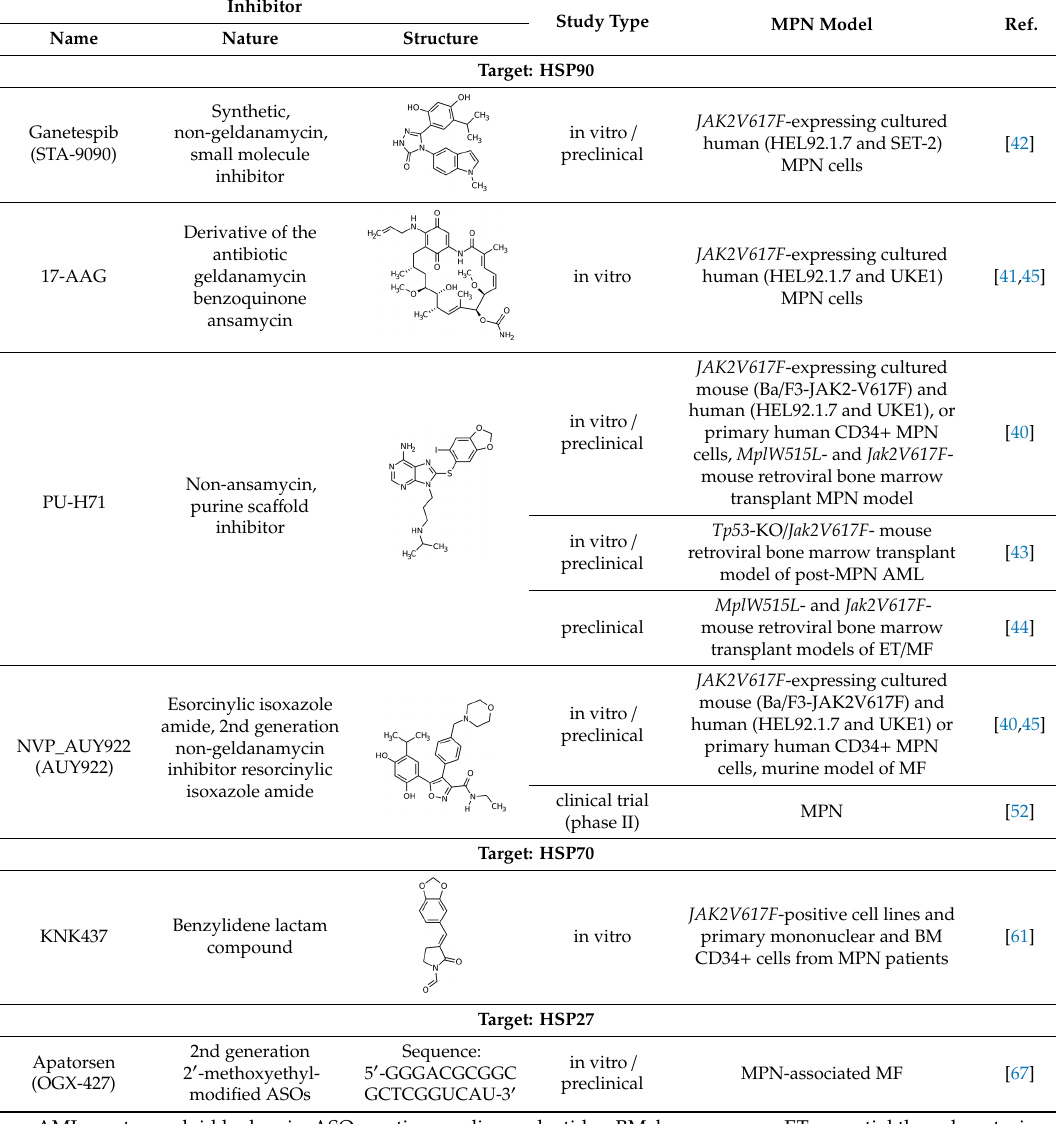
Table 1. Overview of the main strategies for HSP inhibition in MPN. Inhibitor